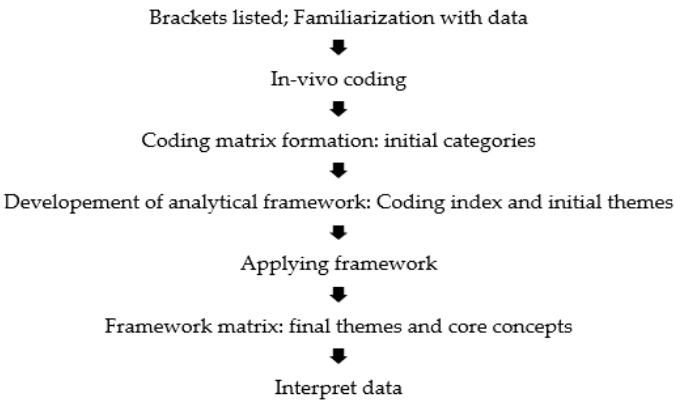
Table 1. Baseline characteristics of study population receiving medical consultation for COVID-19 vaccination.